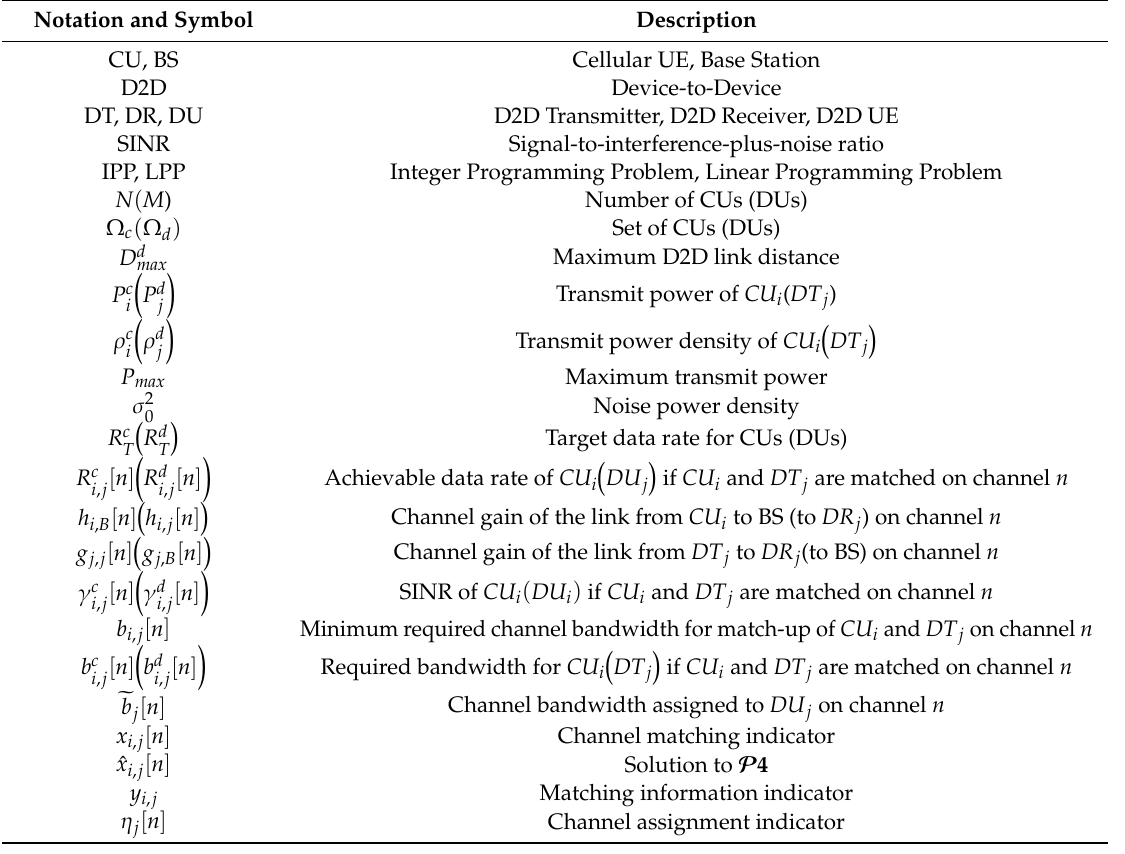
Table A1. A list of the notations and